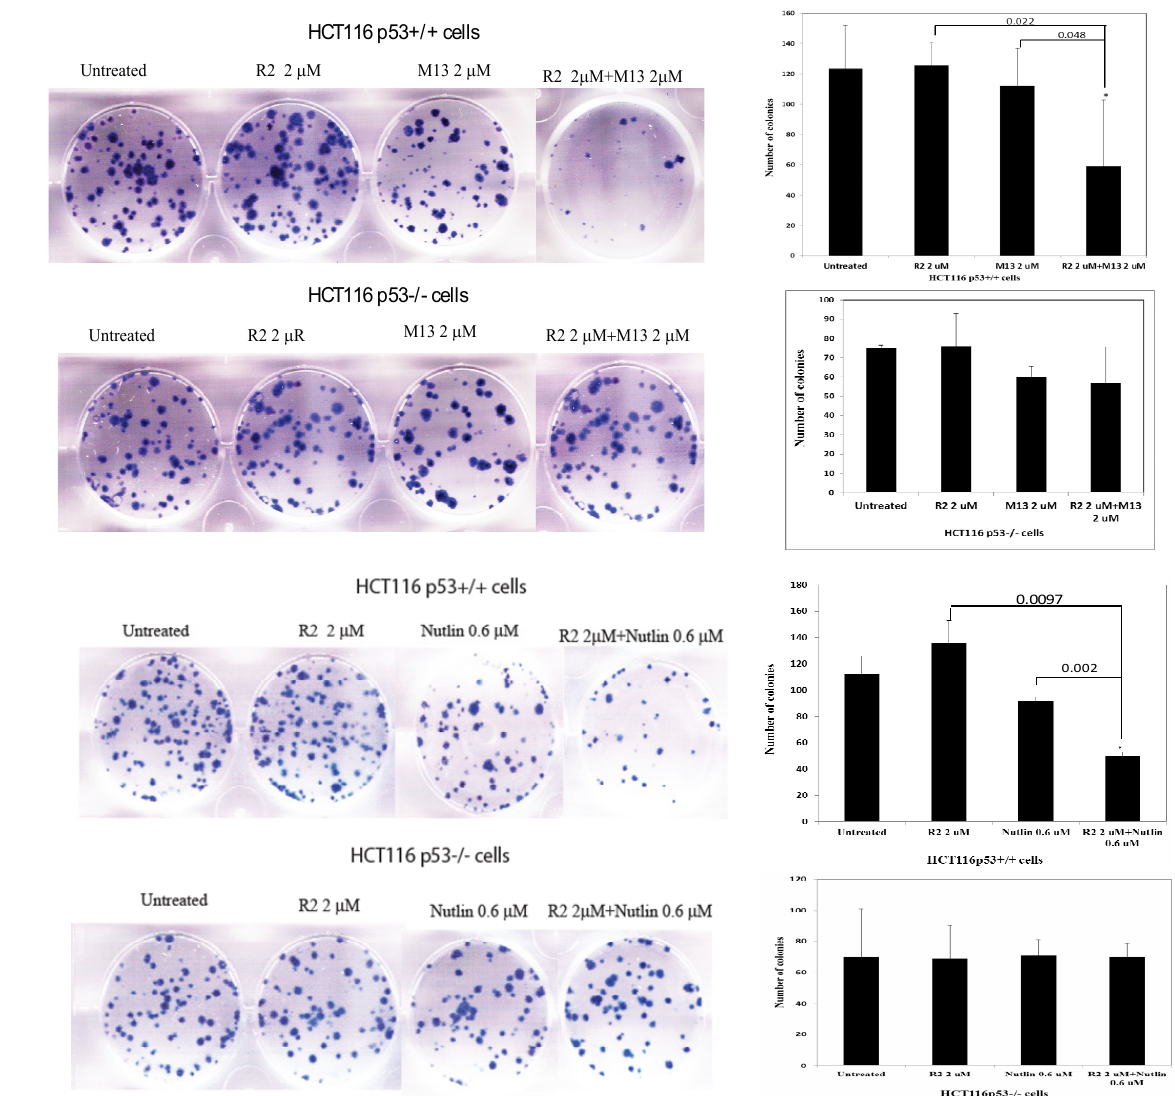
Figure 3. R2 sensitized HCT116 cells to M13 and Nutlin. Clonogenicity assay was performed on HCT116p53 + / + cells or HCT116p53 − / − treated for one week either with